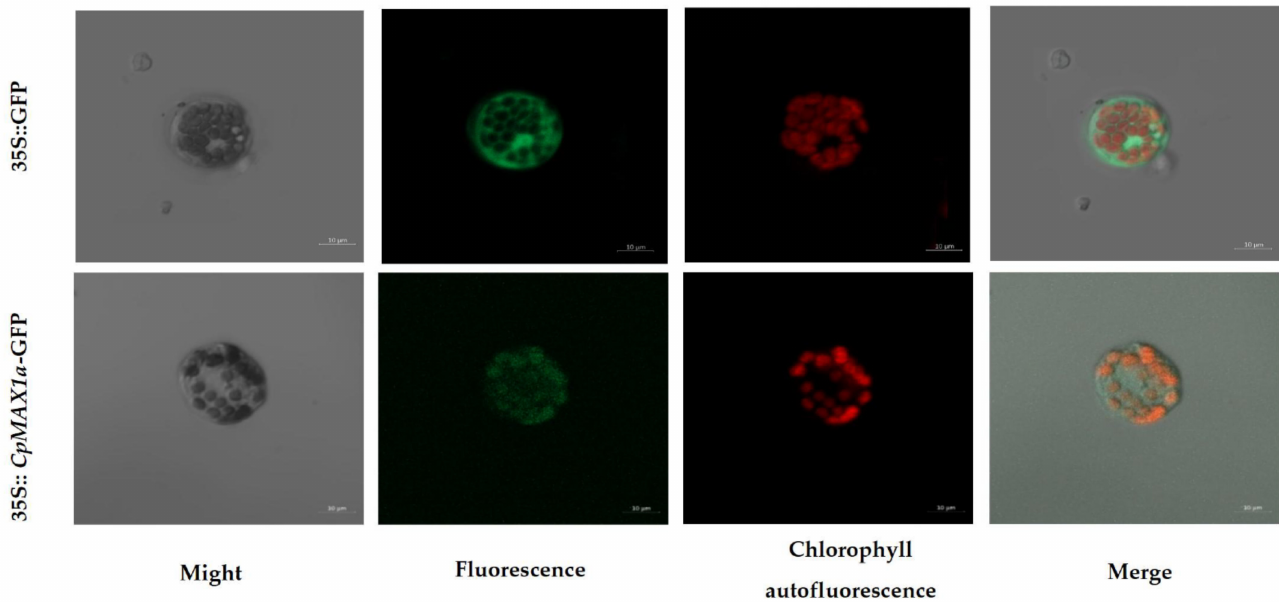
Figure 3. Subcellular localization analysis of GFP-tagged CpMAX1a . GFP-tagged CpMAX1a genes were expressed in Arabidopsis protoplasts. The 35S::GFP construct served as the control. Green color- ing indicates the GFP signal; red coloring indicates chlorophyll autofluorescence; yellow indicates the merged signal. Scale bars: 10 µ